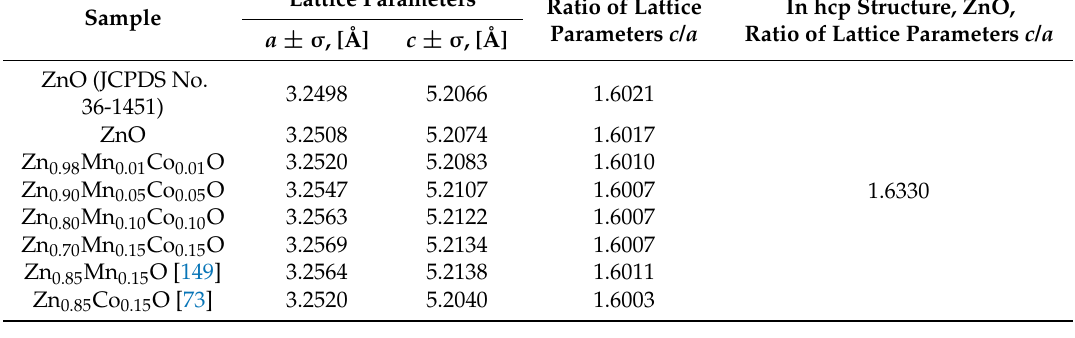
Table 4. Lattice parameters and ratio of lattice parameters of the obtained Zn (1 − x − y) Mn x Co y O NPs.